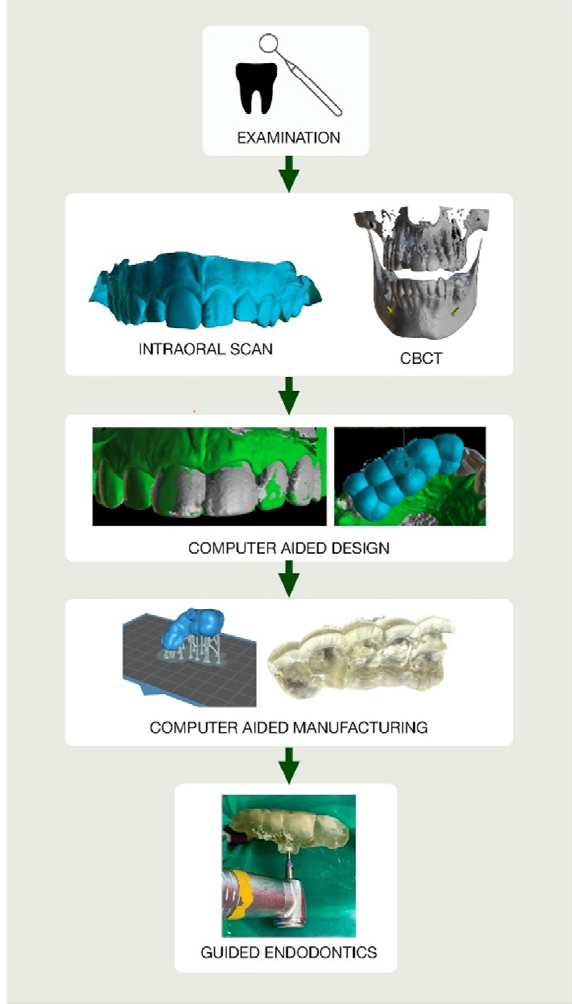
Figure 7. Flowchart illustrating the entire digital workflow’s steps to deliver endodontic guide.